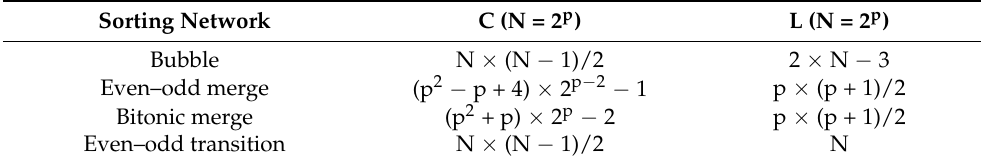
Table 1. Parameters of the analyzed sorting networks.